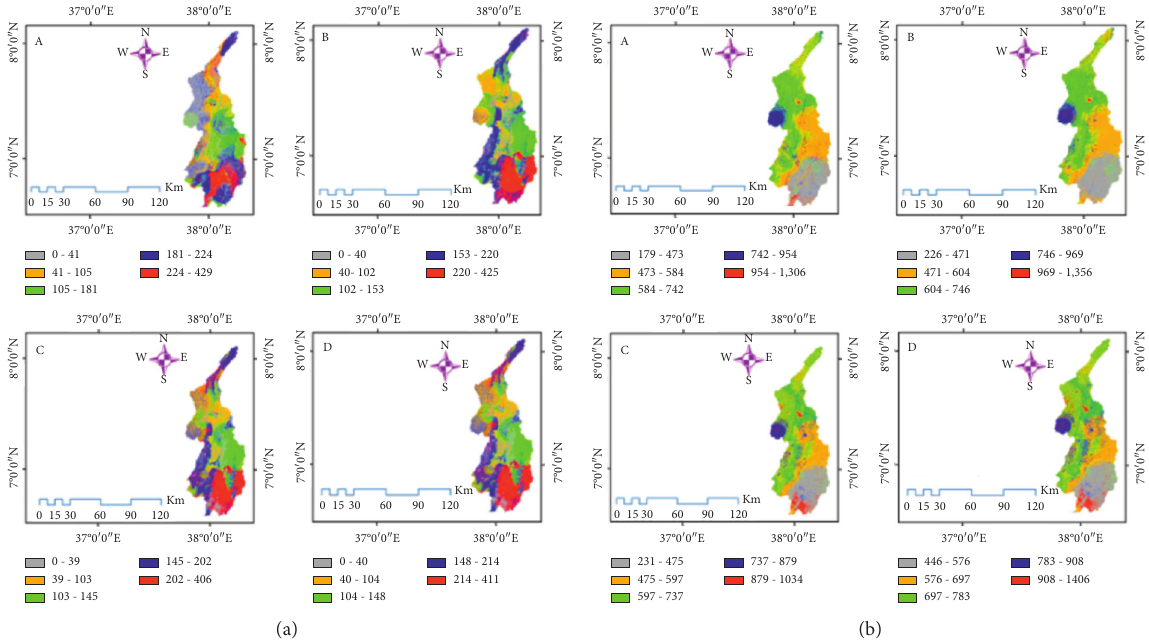
Figure 11: Maps of water balance components simulated with the WetSpass model (a) and (b) at each LULC classes of (A) 1989, (B) 1999, (C) 20011, and (D) 2019. Table 11: Long-term seasonal WetSpass-M simulated surface runoff (mm) of the Bilate basin for a LULC (1989, 1999, 2009, and 2019). Winter surface runoff Spring surface runoff Summer surface runoff Autumn surface